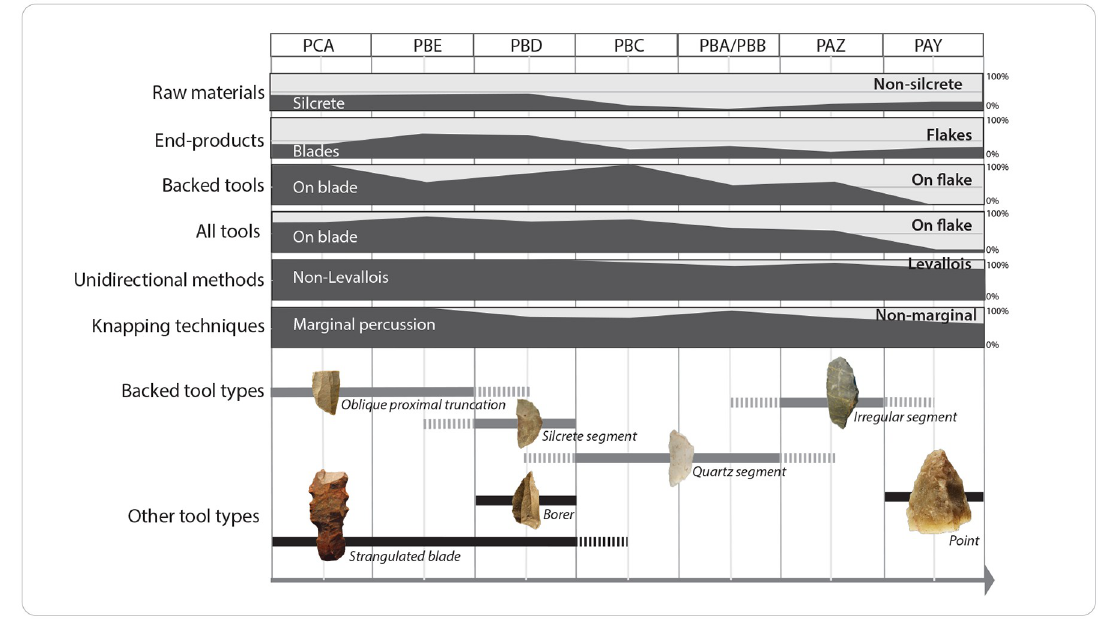
Fig 9. Pattern of techno-typological changes in lithic assemblages through the HP sequence at KDS.